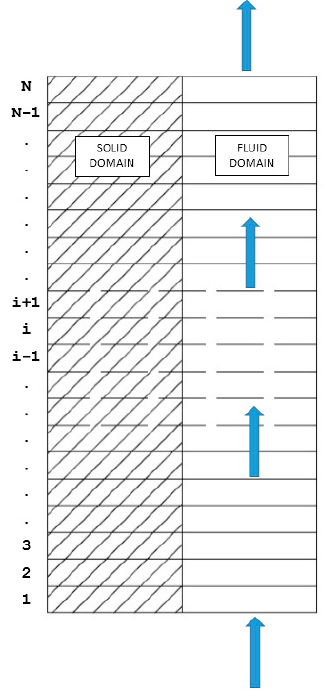
Appl. Sci. 2019 , 9 , x FOR PEER REVIEW Figure 2. Sketch of a single chamber domain discretization. Figure 2. Sketch of a single chamber domain discretization.